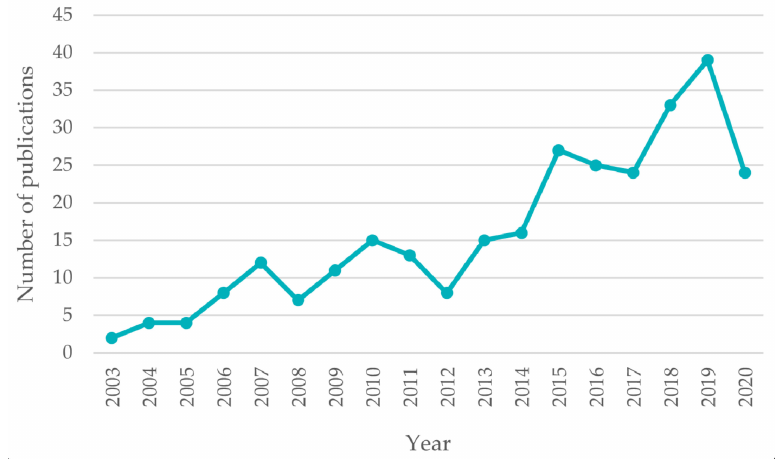
Figure 1. The growing number of publications on the topic of microfluidic-microwave devices. Based on the data obtained from Scopus [16].